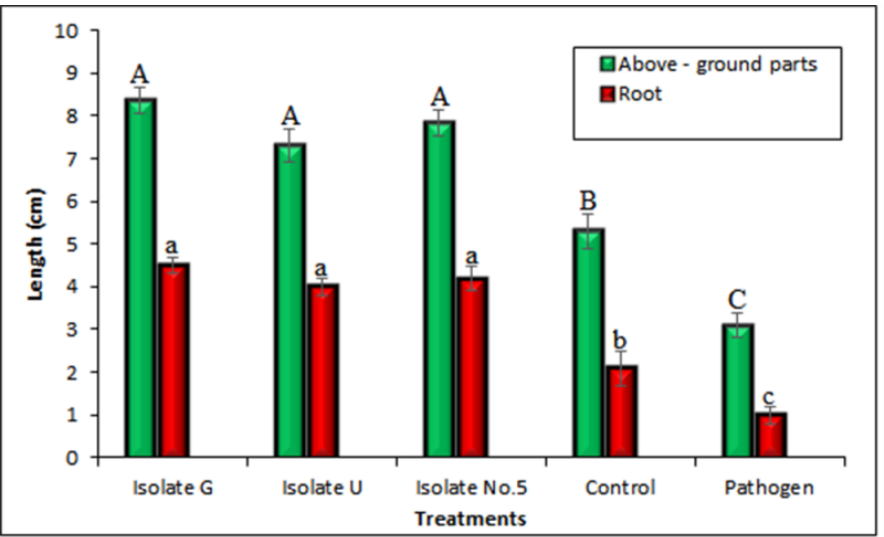
Figure 8. Rice plants’ longitudinal root growth ratios after in vivo inoculation. The standard deviation is shown by error bars. Duncan’s Multiple Range Test reveals a significant difference between the means denoted by various letters ( p ≤ 0.05). Different letters represent significant